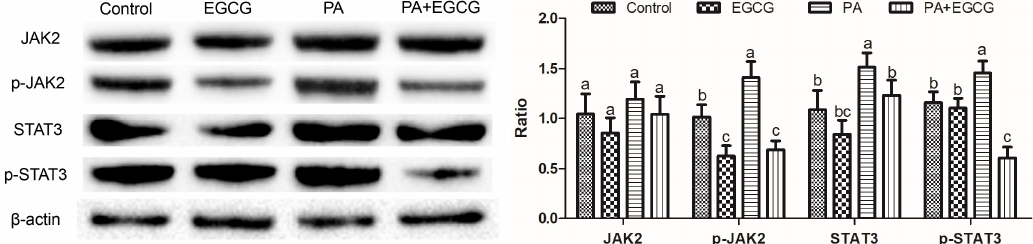
Figure 2. Inhibition effect of (−)-epigallocatechin gallate (EGCG) on JAK2/STAT3 signaling activation in PA-stimulated BV-2 cells. BV-2 cells were pretreated with 20 μM EGCG for 2 h and then stimulated with 200 μM palmitic acid for 24 h. Representative Western blots for JAK2 and STAT3 phosphorylation in BV-2 cells were shown. Data are means ± SEM of three independent experiments performed in triplicate. Different superscript letters indicate significantly different means at p < 0.05 (a > b > c).